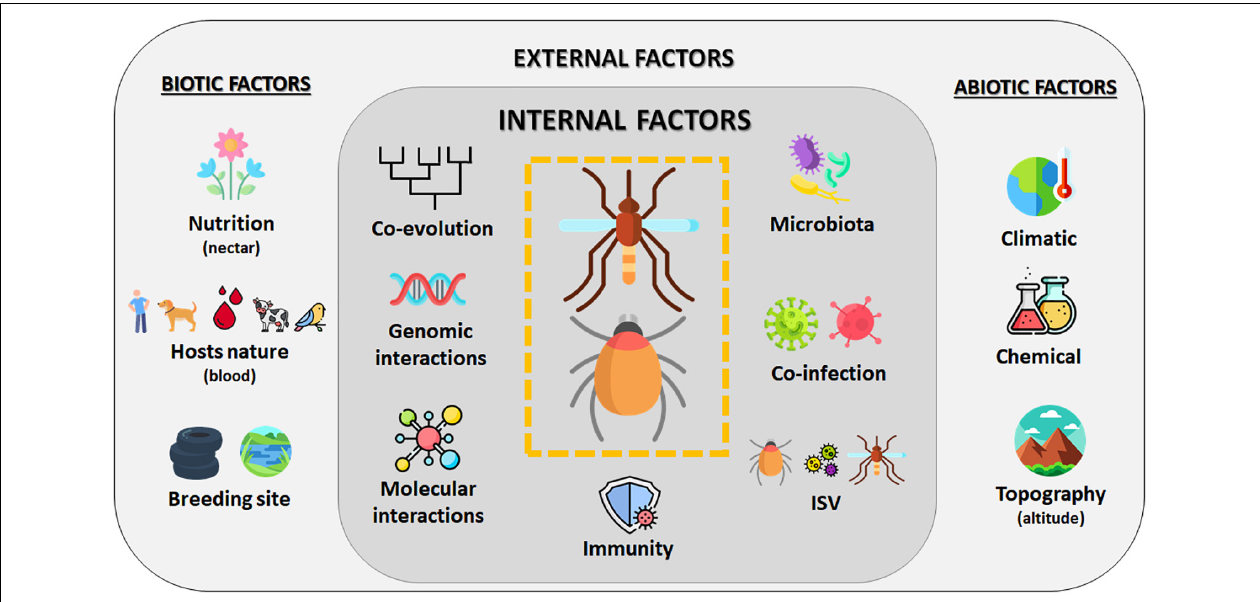
FIGURE 4 | Overview of factors influencing the vectorial system. Vector capacity results from complex interactions of multiple factors influencing pathogen transmission by a vector. Internal factors like genetic, evolution, immunity, or interactions with other microorganisms are modulated by external parameters such as abiotic (like climate or topography) and biotic (like nutrition or hosts) factors (Lefevre et al., 2013). Created with Flaticon.com.